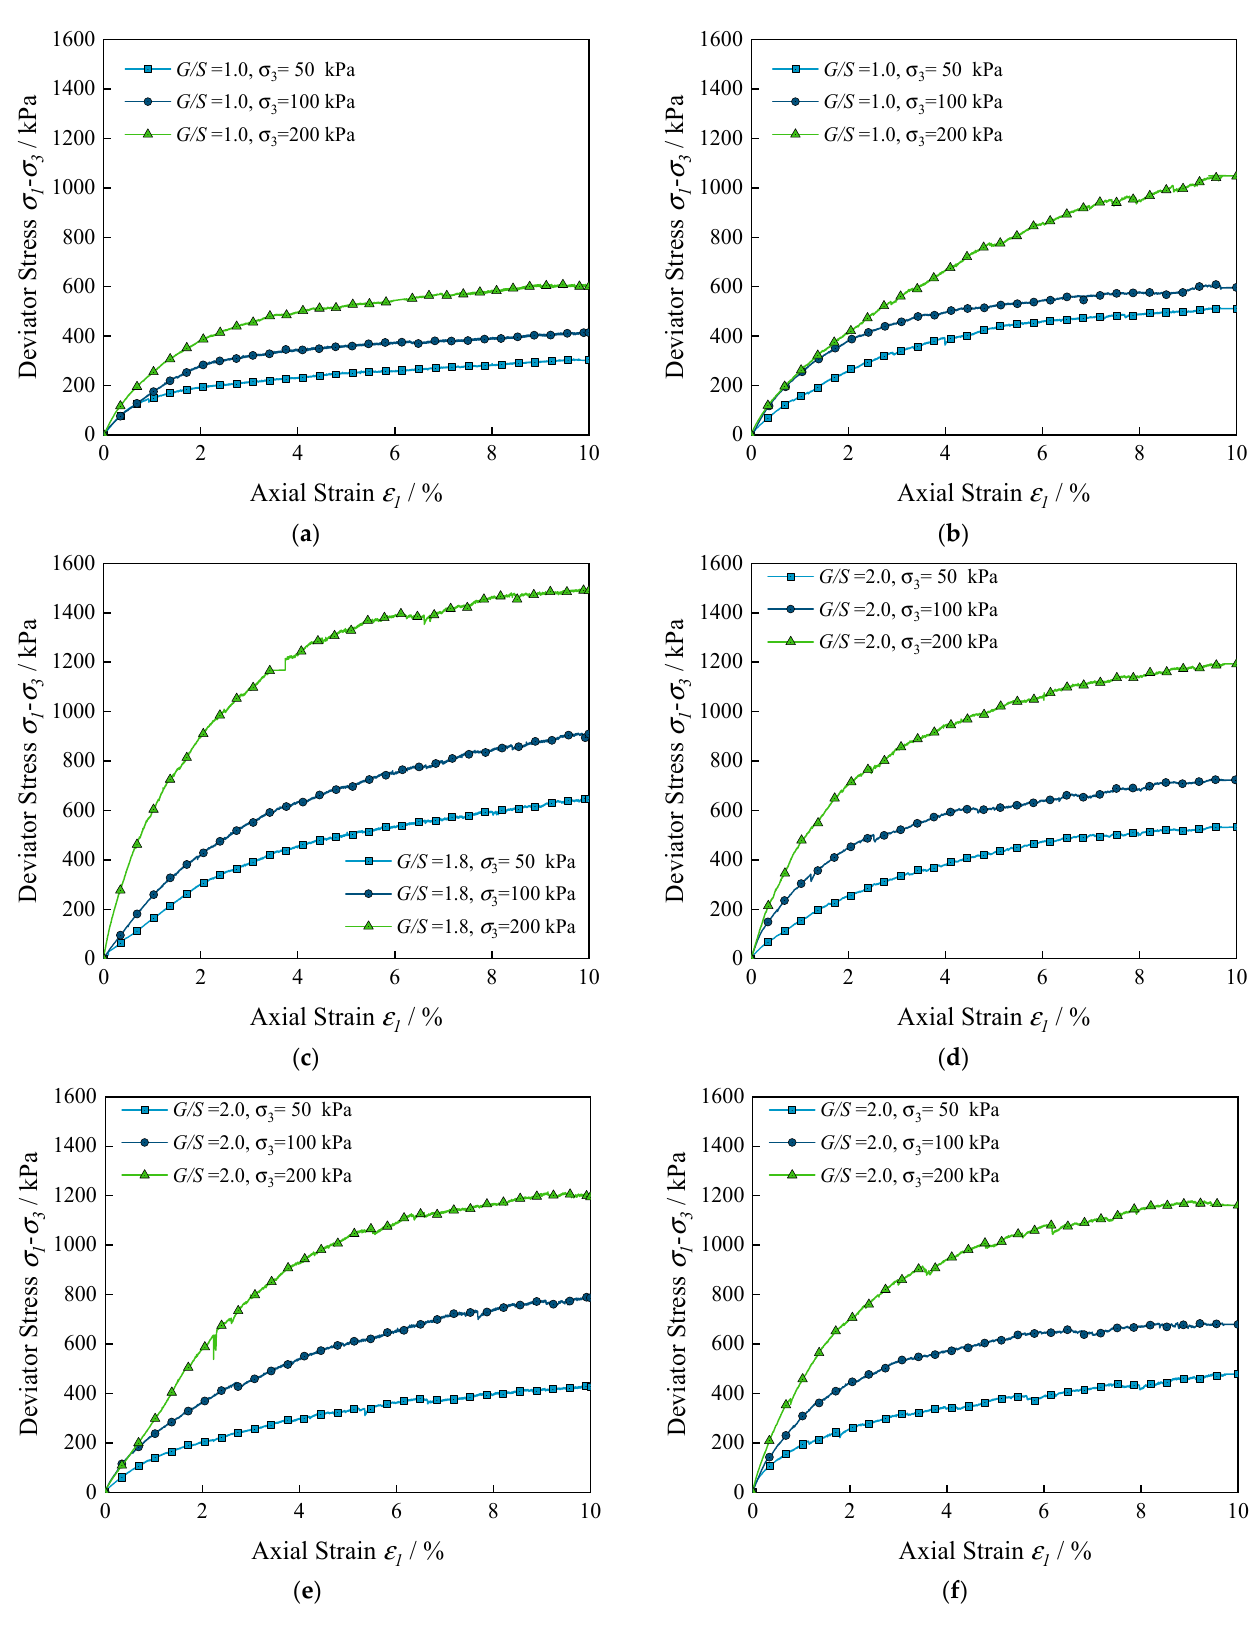
Figure 7. Laboratory-tested deviator stress versus axial strain curves of UPAB specimens with varying G/S levels: ( a ) G/S = 1.0; ( b ) G/S = 1.6; ( c ) G/S = 1.8; ( d ) G/S = 2.0; ( e ) G/S = 2.2; and ( f ) G/S = 2.5.